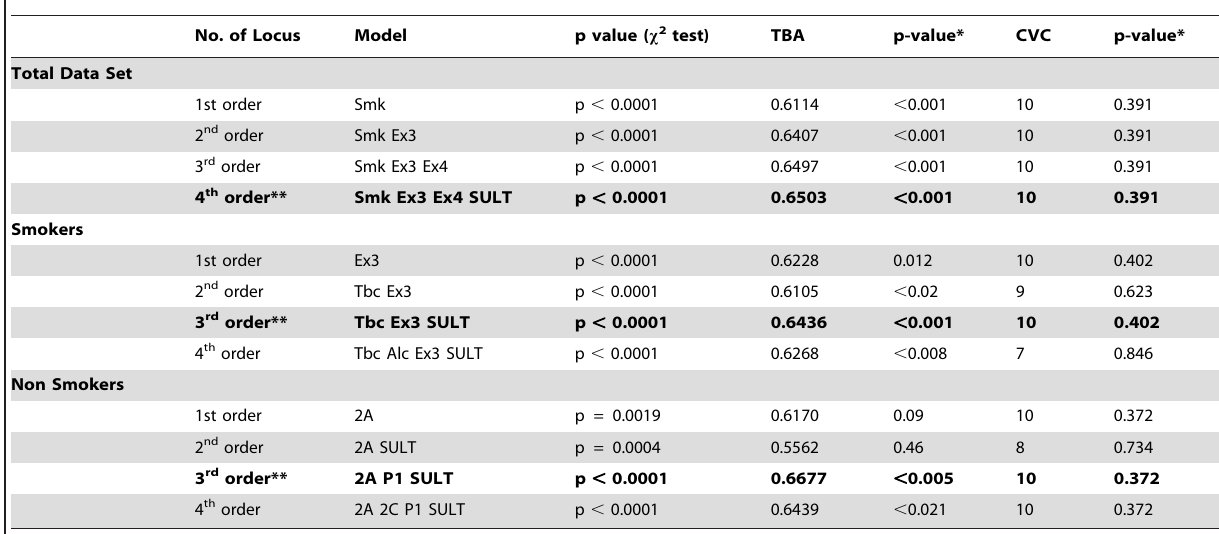
Table 4. Results of MDR